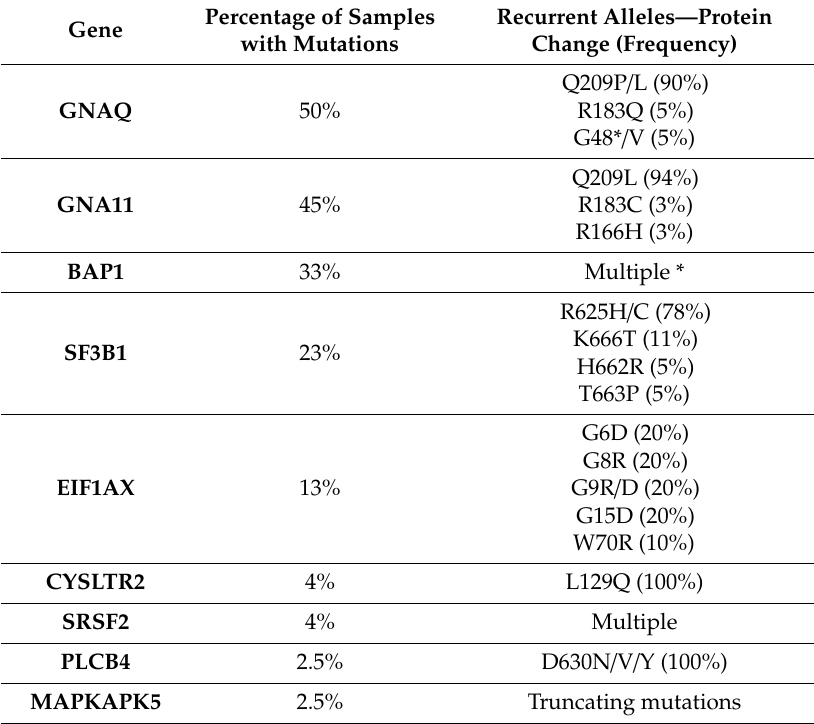
Table 1. Genes frequently mutated in uveal melanoma. Source: cBioPortal [39,40]. Percentage of Samples Recurrent Alleles—Protein Gene with Mutations Change (Frequency) Q209P / L GNAQ 50%